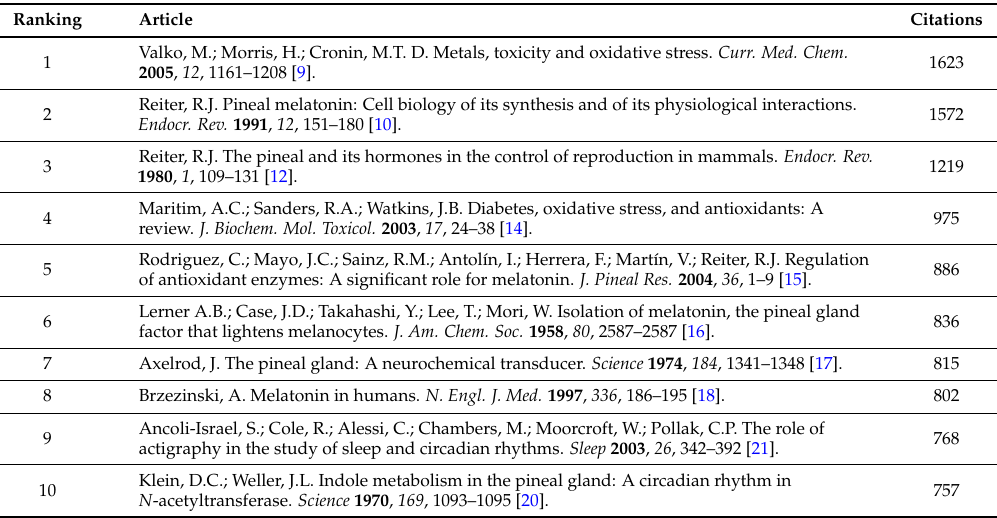
Table 3. The top 10 most cited reviews.